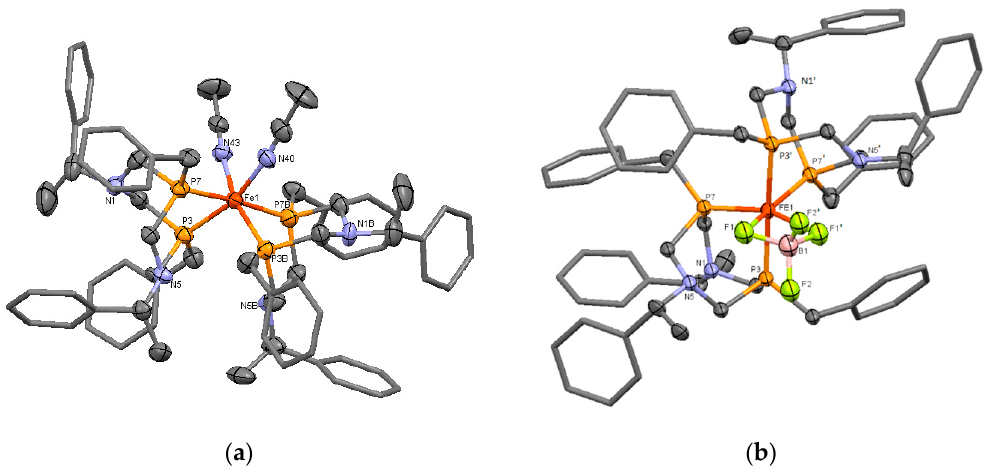
Figure 2. ( a ) The molecular structure of the cation of the complex 8 . Hydrogen atoms, anions BF 4 , and solvate molecules (acetonitrile) were omitted for clarity; Bond distances Fe1-P3 2.233(3), Fe1-P7 2.232(3), Fe1-P3B 2.246(3), Fe1-P7B 2.242(3), Fe1-N40 1.960(10), Fe1-N43 1.940(9) Å, ( b ) The molecular structure of the cation of the complex 11b . Hydrogen atoms, disordered anions, and solvate molecules were omitted for clarity. Bond distances Fe1-P3 2.267(3), Fe1-P7 2.209(4), Fe1-F1 2.050(8) Å. Both diazadiphosphacyclooctane ligands (N(1)P(3)N(5)P(7) and N(1B)P(3B)N(5B)P(7B)) had